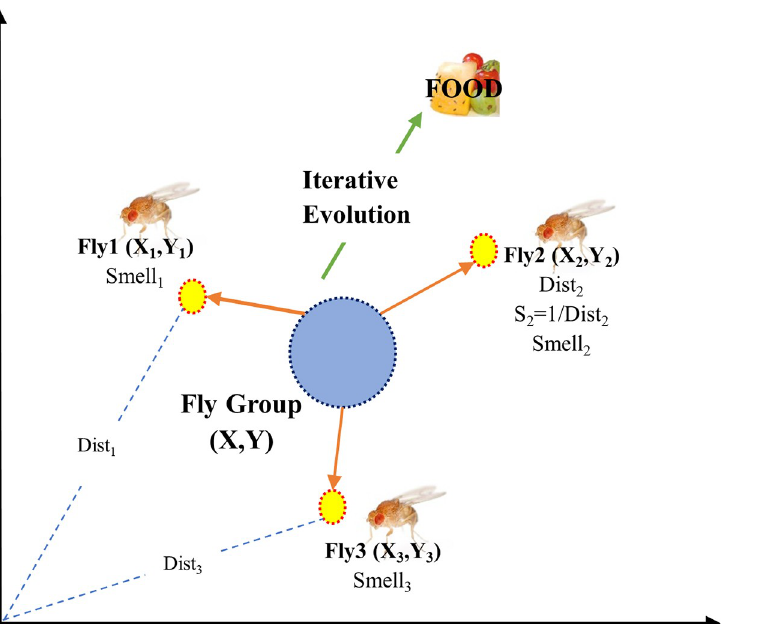
Fig 3. The schematic view of the fruit fly optimization algorithm